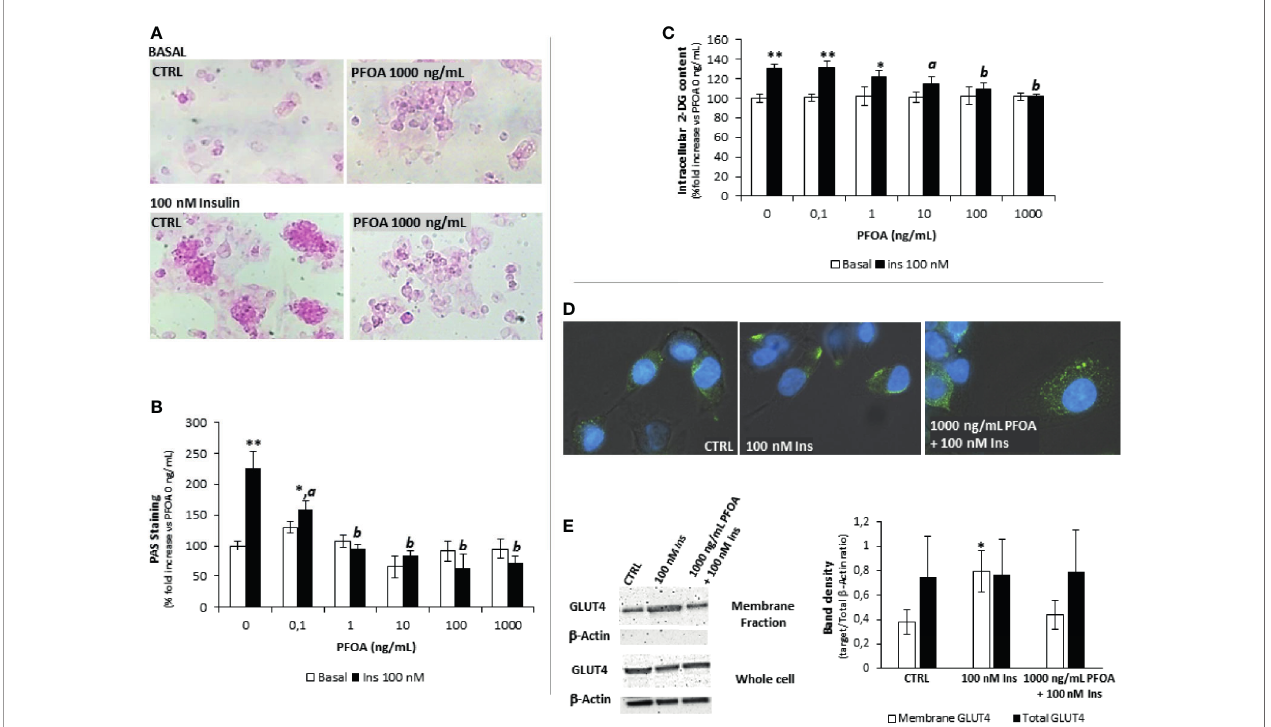
FIGURE 1 | (A) Representative images of Periodic Acid Schiff (PAS) staining in HepG2 cells, in basal condition and after stimulation with 100 nm insulin (Ins), exposed for 24h to per fl uoro-octanoic acid (PFOA) at the concentration of 0 (CTRL) and 1000 mg/mL. The histogram plot in (B) shows the corresponding results of image analysis on PAS staining intensity. Data are reported as the percentage fold increase compared to control condition, in which both PFOA and Ins were omitted, and represent the mean value of three independent experiments. Signi fi cance: *P<0,05 and **P < 0,01 respectively vs corresponding basal where Ins was omitted. aP < 0 ,05 and bP < 0,01 vs control + 100 nm Ins. (C) Evaluation of glucose uptake in HepG2 cells by the 2-deoxyglucose (2-DG) assay. Intracellular 2-DG was quanti fi ed in basal condition and after stimulation with 100 nm insulin, after the exposure for 24h to PFAS at increasing concentration. Data are reported as the percentage fold increase compared to control condition, in which both PFOA and Ins were omitted, and represent the mean value of a quadruplicate. Signi fi cance: *P < 0,05 and **P < 0,01 respectively vs corresponding basal where Ins was omitted. aP < 0,05 and bP < 0,01 vs control + 100 nm Ins. (D) Representative images of immuno fl uorescence assay for Glut-4 glucose transporter (green) in HepG2 cells at basal (CTRL) and stimulated with 100 nm Insulin with or without previous exposure to PFOA at the concentration of 1000 ng/mL. Cells were counterstained with DAPI (blue) and merged with bright- fi eld images. Pictures are representative of three independent experiments. (E) Representative images of Western Blot analysis for Glut-4 protein expression in HepG2 cells at basal (CTRL) and stimulated with 100 nm Insulin with or without previous exposure to PFOA at the concentration of 1000 ng/mL, in the whole cell extract and after membrane protein fractionation. b -Actin in the whole cell extract was used as housekeeping. The histogram reports the target band density/total b -Actin density ratio for Glut-4 in the membrane fraction and whole cell extract. Data represent the mean value of three independent experiments. Signi fi cance: *P < 0.05 vs